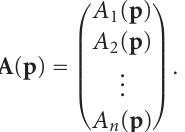
Here, l is the length of the common edge AB . h 1 is the perpendicular distance from the center of the cell P on the edge AB . Similarly h 2 is defined. Let there be total n cells in the mesh (DOF = n ). Each cell in the mesh provides a nonlinear equation (2.4).